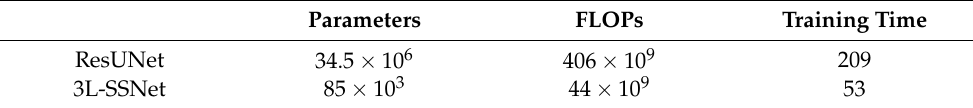
Table 1. A comparison of the cost of the considered networks. The training time is expressed in sec/epoch in the third